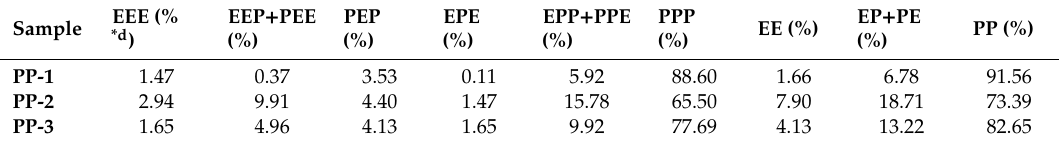
Table 5. The triad and diad distributions of ethylene / propylene copolymers obtained by 13 C NMR.